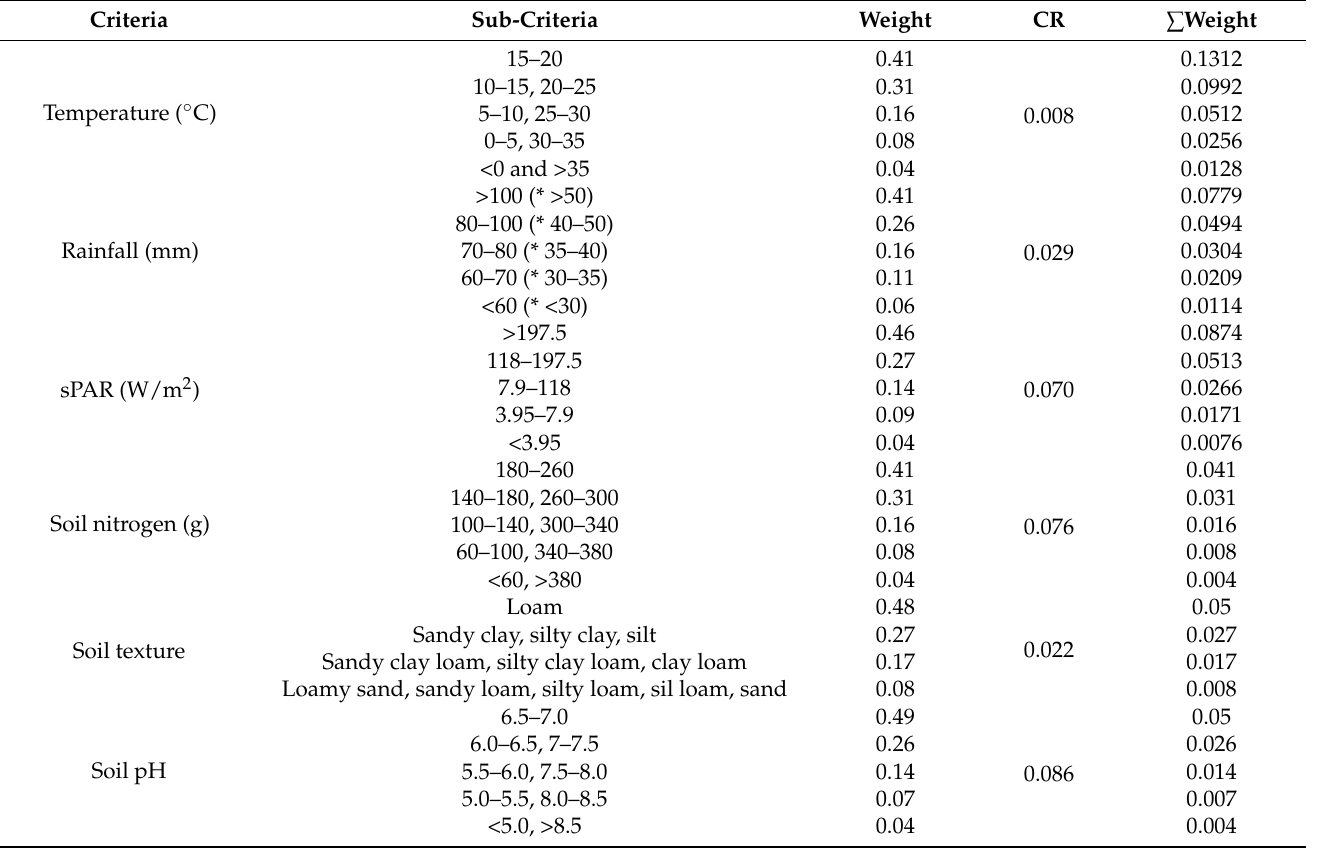
Table 3. Weights of all criteria for agricultural lands in the study